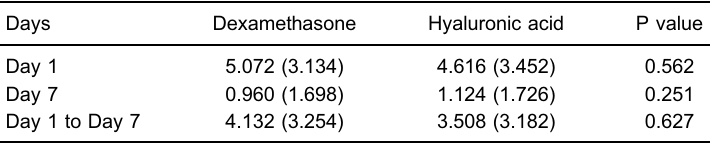
Data are reported as mean and standard deviations in mm 2 for n=52 children/ group ( t -test). Table 3. Comparison of numeric rating scale variation for pain in children with recurrent aphthous ulcers treated with dexamethasone or hyaluronic acid. Days Dexamethasone